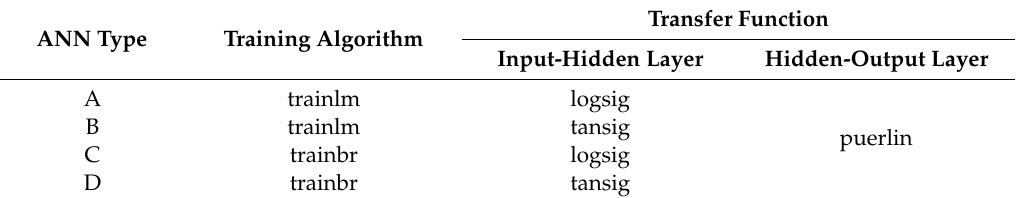
Table 2. Neural network models investigated for microfiltration